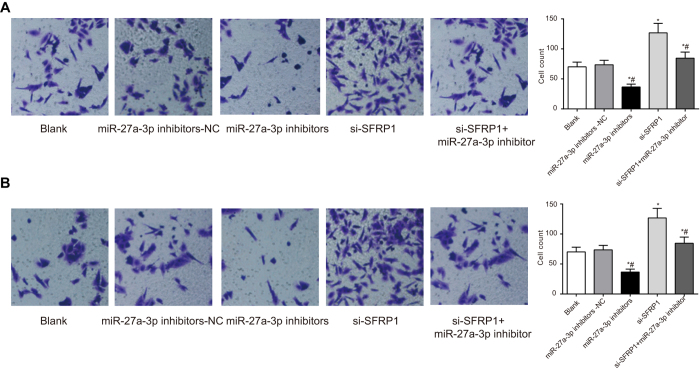
The migration ability of OSCSCs in the miR-27a-3p inhibitors, miR-27a-3p inhibitors-NC, si-SFRP1, si-SFRP1 + miR-27a-3p inhibitors and blank groups detected by a Transwell assay after transfection (400×).(A) Transwell images and histogram showing the migration of SCC-9 OSCSCs in the five groups; (B) Transwell images and histogram showing the migration of Tca8113 OSCSCs in the five groups. *Represents P < 0.05 comparisons with the blank and miR-27a-3p inhibitors-NC groups. #Represents P < 0.05 compared with the si-SFRP1 group; OSCSCs, oral squamous carcinoma stem cells.